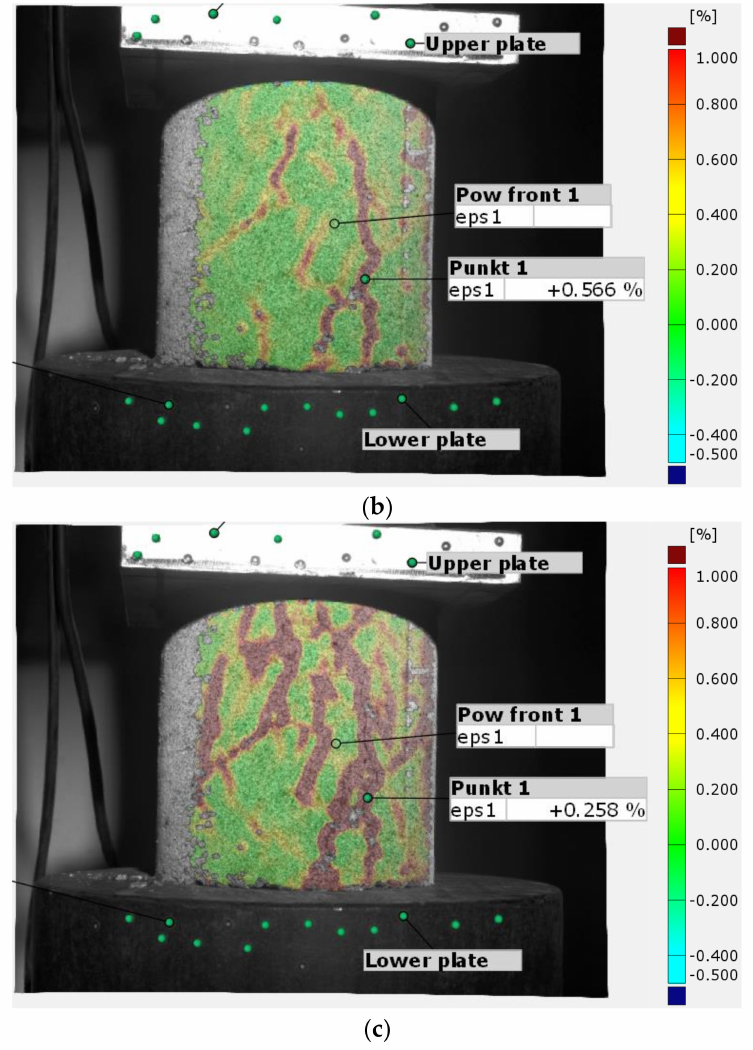
Figure 10. Inspection of major strain in a scratch during its propagation in: ( a ) The beginning of the load; ( b ) before peak load; ( c ) after the peak